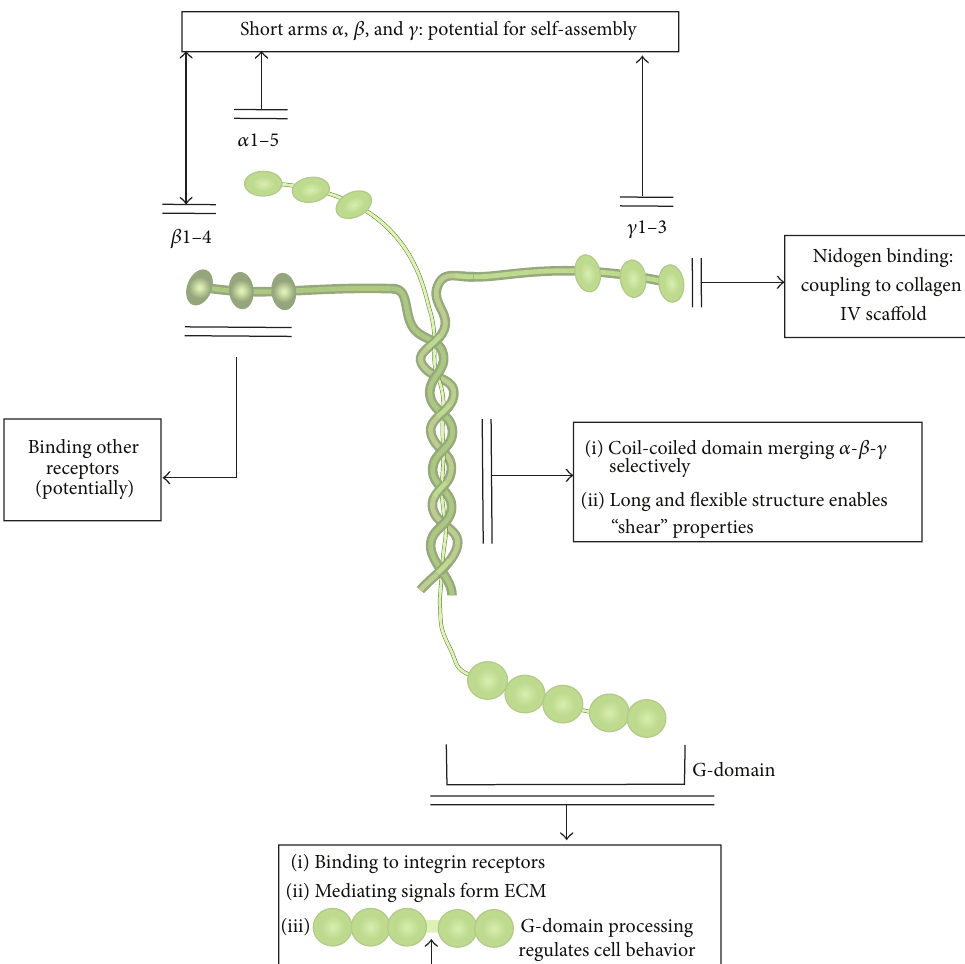
Figure 3: Laminins: a model system to investigate roles of molecular complexity of natural matrix molecules . Natural extracellular matrix molecules are very large and complex molecules, often composed of more than one polypeptide chain (collagens have 3 chains, laminins have 3 chains, and fibronectin has 2 chains) and multiple domains with distinct adhesive and geometrical properties. Mutations in either chains or domains often result in severe pathology. Apparently, such molecular complexity developed during evolution for a reason, and natural ECM molecules have more function, compared to small adhesive peptides. However, it is not easy to establish roles for each specific domain and structure of the natural large ECM molecules. Family of laminins, due to their molecular versatility, is a perfect model system to investigate reasons for functional complexity of matrix molecules. Laminins are the natural adhesion ligands for many stem cell types, like embryonic stem cells (ESC), hematopoietic stem cells, sperm stem cells, and probably many others. Due to unique composition of three heterogeneous chains, each of which can be varied, cell adhesion domains undergoing natural proteolytic maturation and, therefore, change in affinity and specificity, availability of conditional knockout models, and mutated proteins in laminin family are an excellent system to investigate reasons for molecular complexity of natural matrix molecules. Laminins are large, heterotrimeric molecules that comprise one 𝛼 , one 𝛽 , and one 𝛾 chain. Size of laminin trimer varies from 400 to 1000kDa. Five 𝛼 ( 𝛼 1– 𝛼 5), four 𝛽 ( 𝛽 1– 𝛽 4), and three 𝛾 ( 𝛾 1– 𝛾 3) chains are known in mammals. Laminin-521 (LM-521) consists of 𝛼 5, 𝛽 2, and 𝛾 1 chains. The molecule in the figure represents the cross-shaped laminin isoform; however, some laminin isoforms have truncated shapes: Y-like or rod-like shape. The 𝛼 1, 𝛼 2, 𝛼 3B, and 𝛼 5 trimers are cross-shaped, while the 𝛼 3A and 𝛼 4 trimers are Y-shaped or rod-shaped. Short arms of laminins (N-terminal parts of 𝛼 , 𝛽 , and 𝛾 chains) can bind other laminins short arms and other ECM proteins. Laminins in solution are capable of self-assembly via N-terminal short arms in the presence of